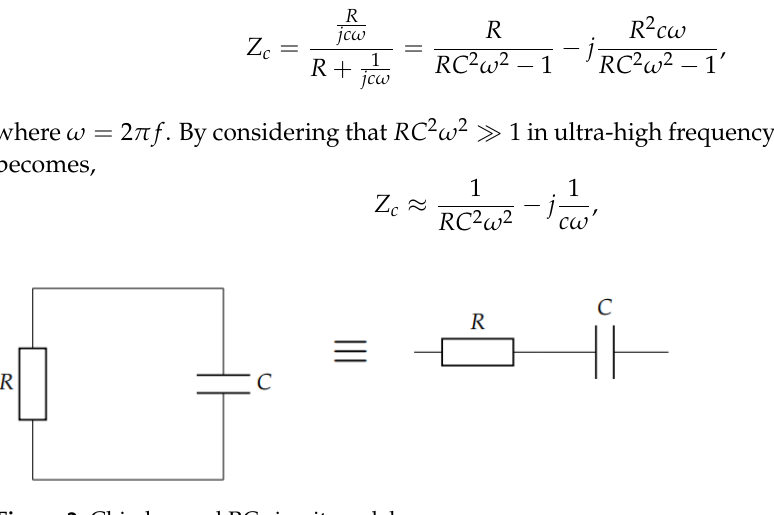
Figure 2. Chip lumped RC circuit model.